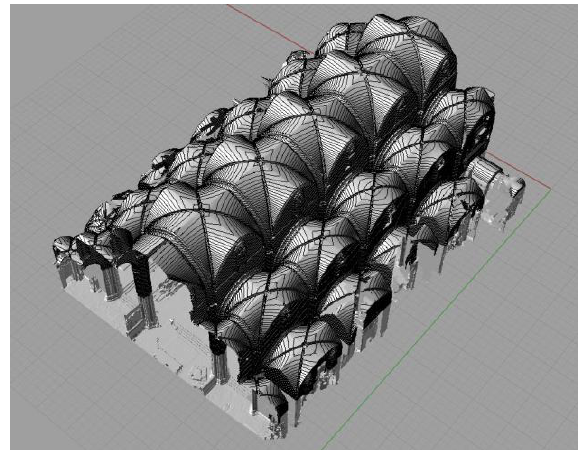
Figure 3. Topography of the vaults of Tortosa's Cathedral (1441-1575).